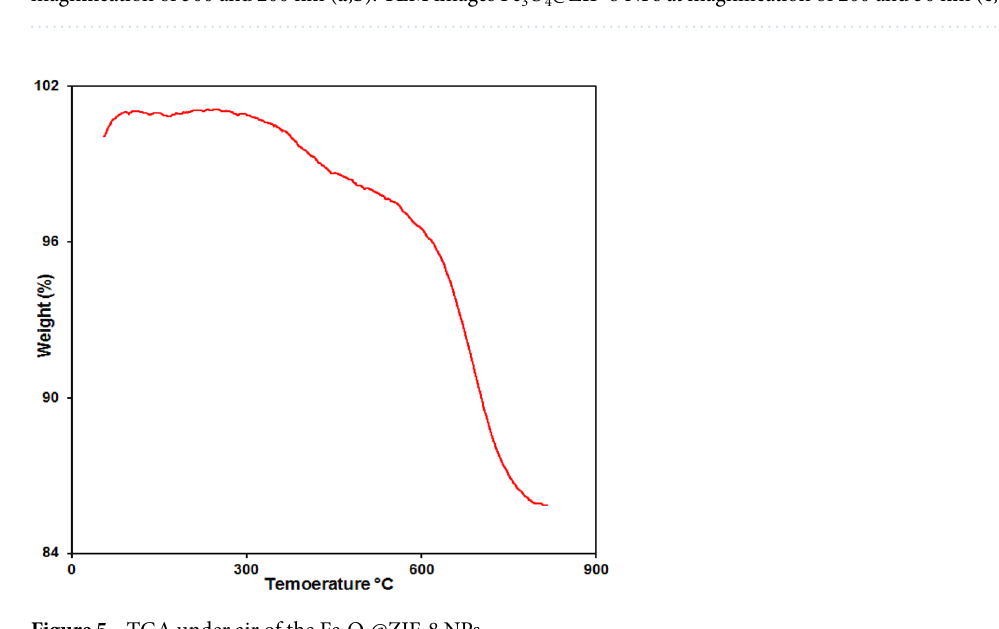
Figure 4. FESEM images of Fe 3 O 4 @ZIF-8 with average diameters of 36.66, 43.39 and 44.28 nm, at magnification of 500 and 200 nm ( a , b ). TEM images Fe 3 O 4 @ZIF-8 NPs at magnification of 200 and 50 nm ( c , d ).